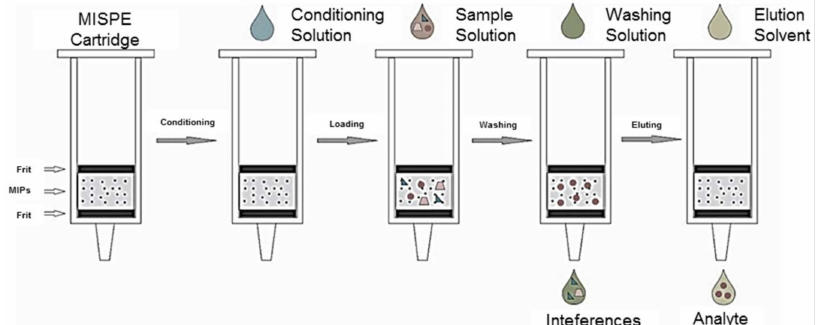
Figure 14. MISPE procedure